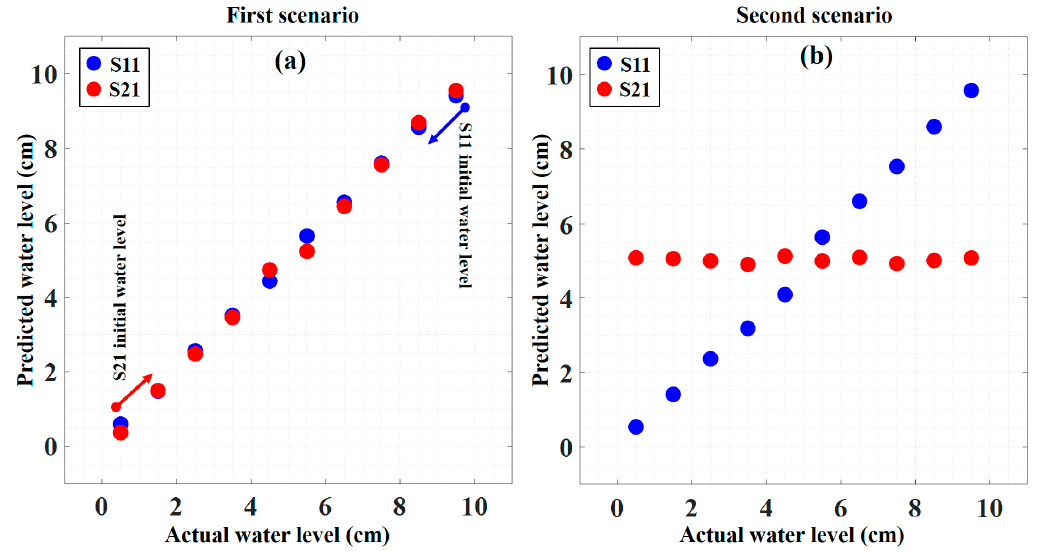
Figure 6. The predicted water level versus the actual water level for the ( a ) first scenario and ( b ) second scenario.